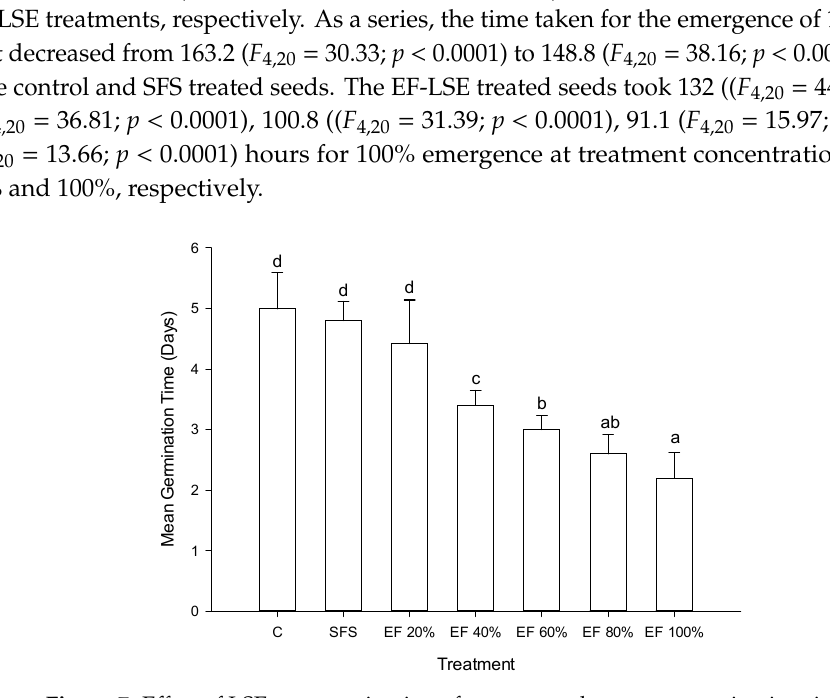
Figure 7. E ff ect of LSEs on germination of tomato seeds—mean germination Figure 7. Effect of LSEs on germination of tomato seeds—mean germination time. Figure 7. Effect of LSEs on germination of tomato seeds—mean germination time.